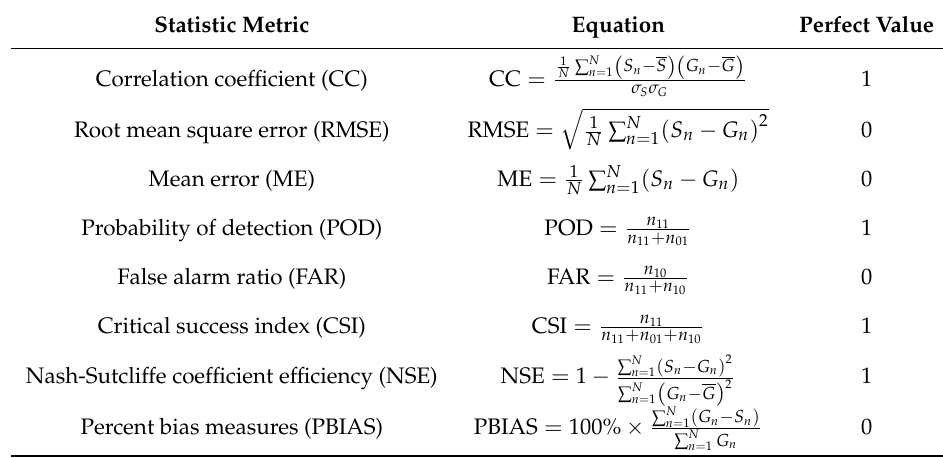
Table 2. List of statistical metrics used in statistical evaluation and SWAT simulation and their perfect